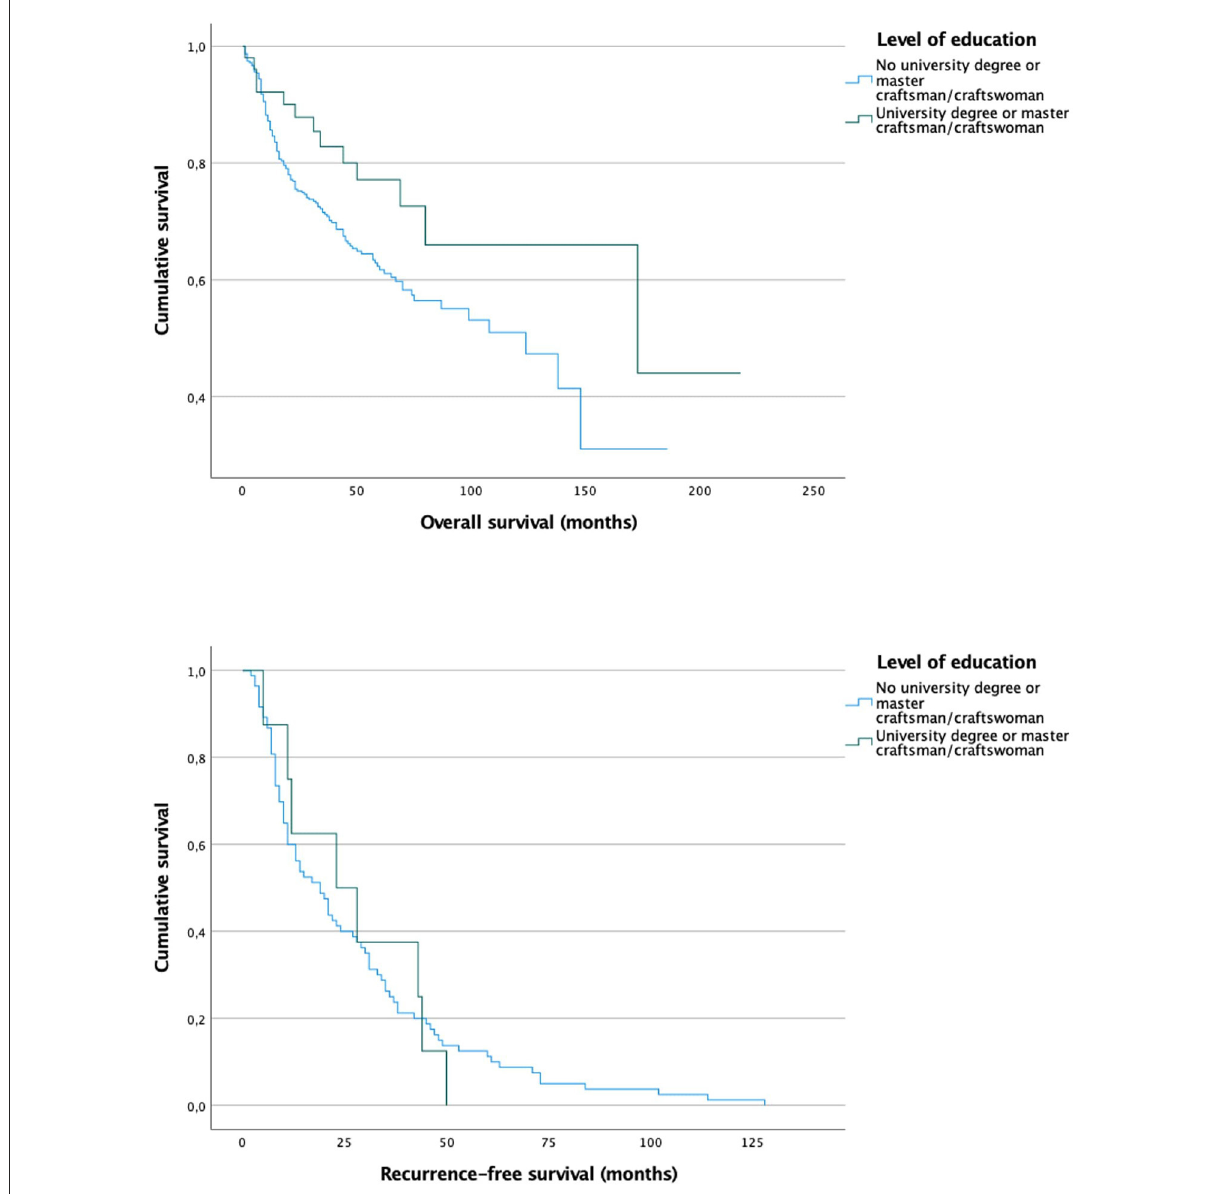
FIGURE1 Survival curves for patients with (mean overall survival 12.3 years) and without (mean overall survival 8.6 years) university degree or craftsmen/craftswoman show a significant difference in overall survival ( p = 0.039) but not in recurrence-free survival ( p =